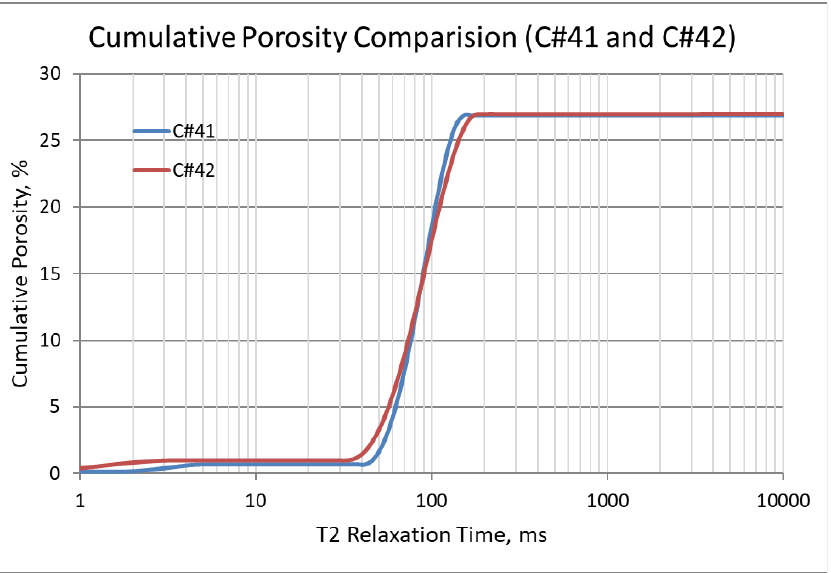
Figure 6. NMR cumulative porosity comparison between C#41 and C#42.